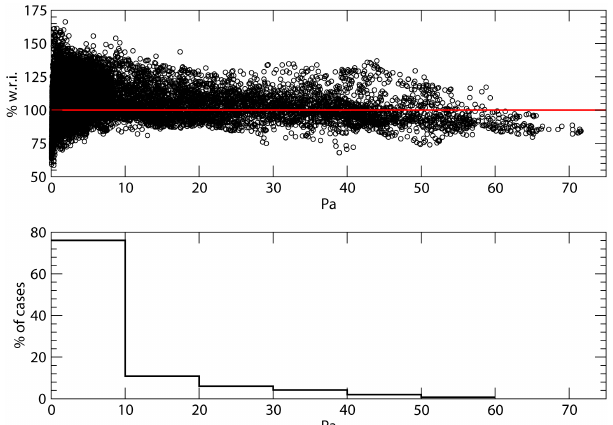
Figure 10. Annual march of the monthly vapor flux at the sur- face according to HMP (red) and HMPmod( green), the black line showing 0 (upper plot), and cumulated difference (HMPmod–HMP, lower plot).